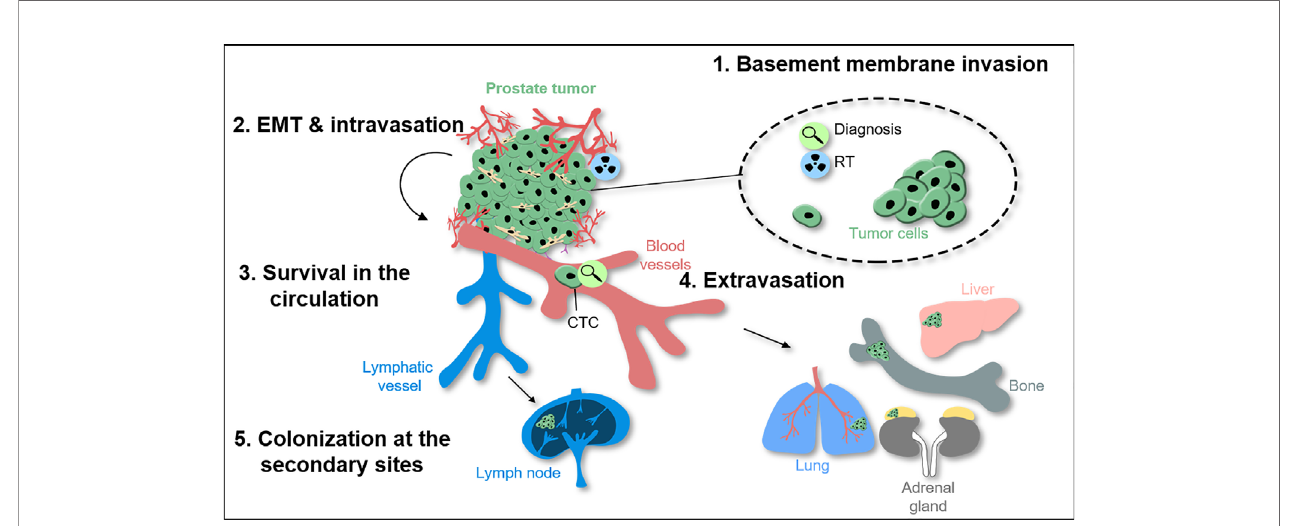
FIGURE 1 | The metastatic cascade in prostate cancer and molecular effects of radiotherapy. During tumor invasion throughout the basement membrane and further migration into surrounding normal tissue, prostate cancer (PCa) cells use epithelial-to-mesenchymal-transition (EMT) as biological program. Intravasation allows tumor cells to enter the circulation including the lymphatic and/or vascular system. To extravasate into distant tissue prostate circulating tumor cells (CTCs) have to attach to the inner vessel wall before leaving the blood system. Once the cells left the circulation they may settle down and colonize secondary organs e.g. within bones as the main metastatic site for PCa